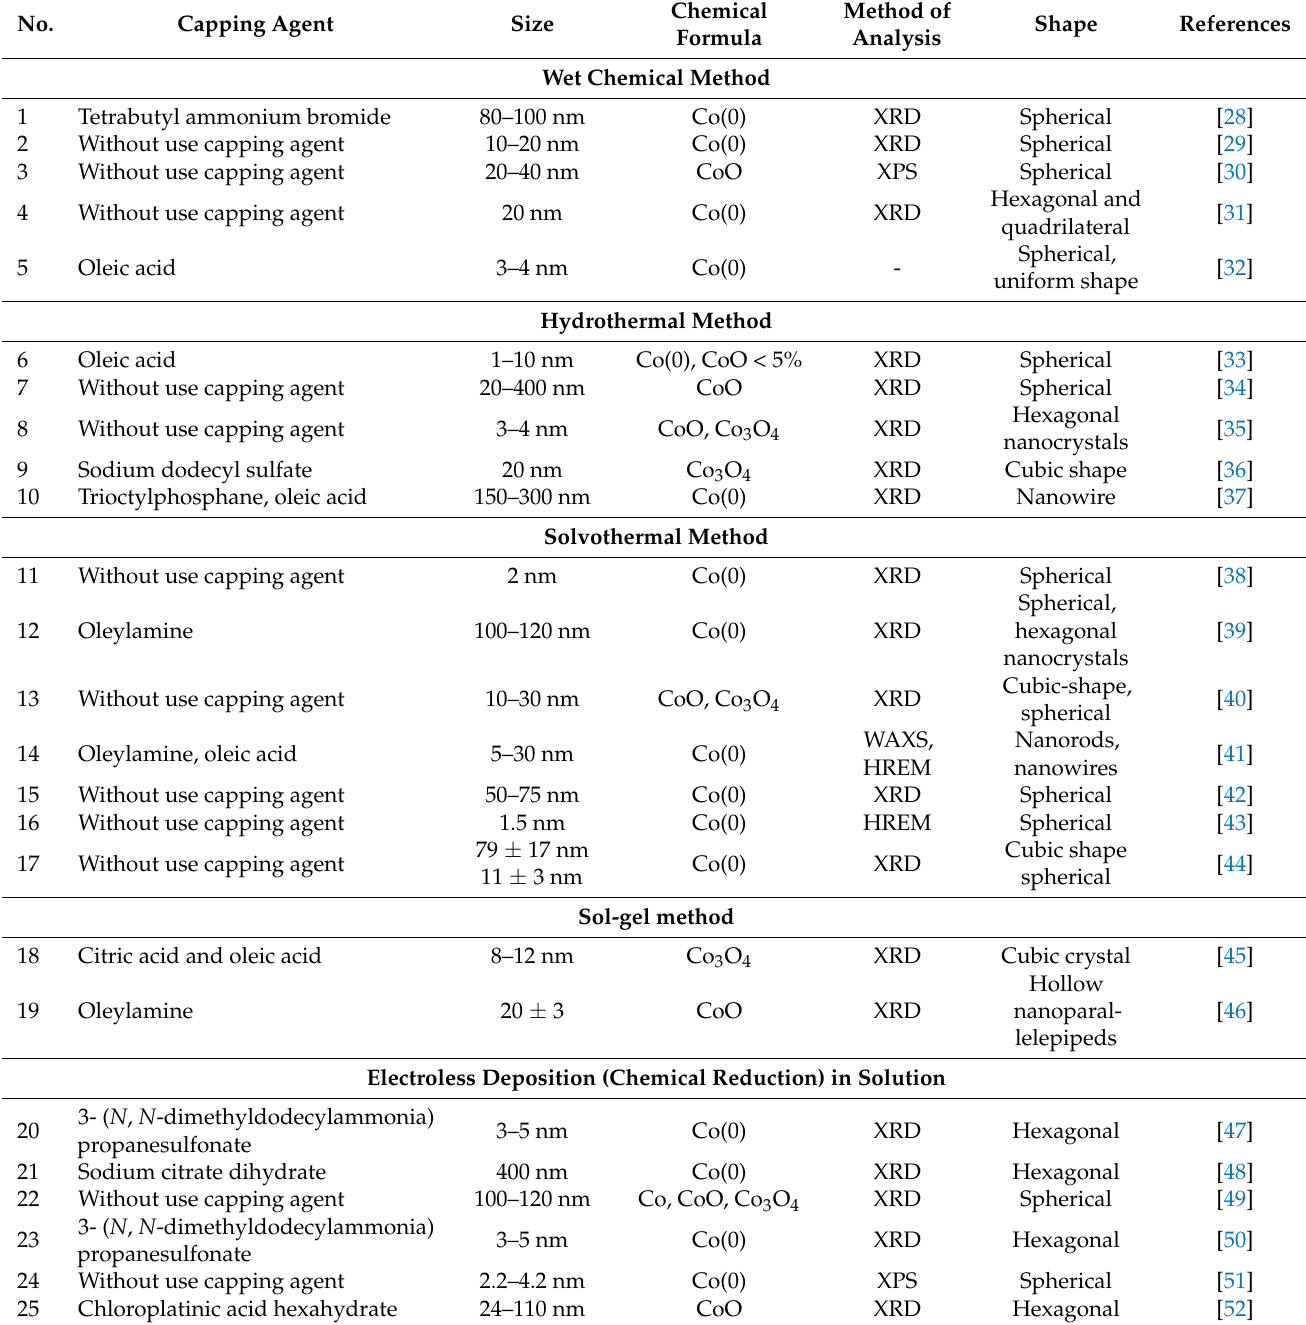
Table 1. Capping agents and synthesis’ methods of